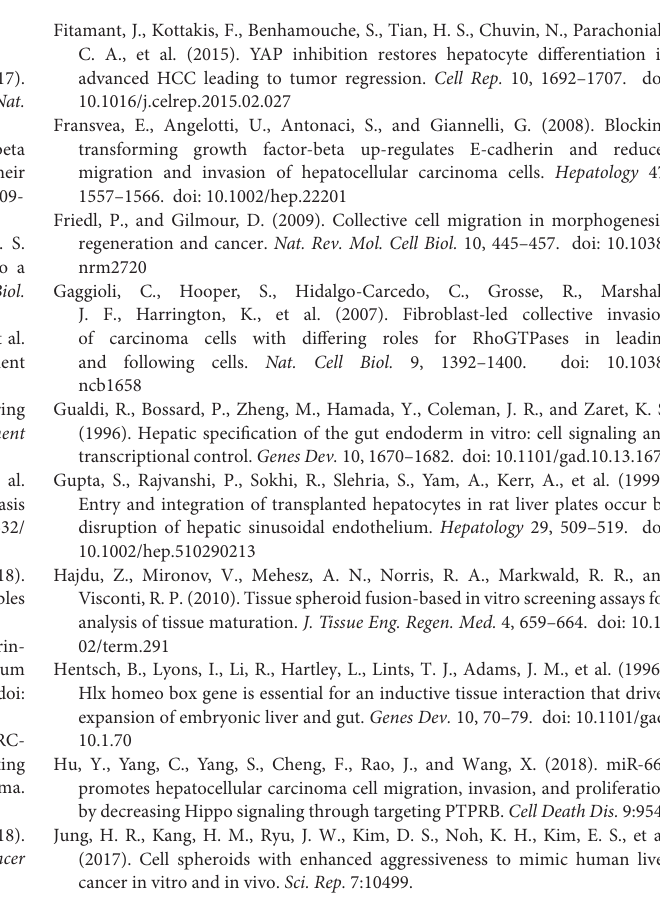
Supplementary Figure 10 | Spheroid outgrowth assay in control and M-CM medium with immunocytochemistry for E -cadherin. HepG2 spheroids seeded Supplementary Figure 11 | Images obtained of day 7 HepG2 MG droplet culture systems in MRC-5-conditioned media (MCM) and control experimental conditions (serum containing DMEM). The MCM condition is a lighter pink color than the control condition which is supportive evidence for the degradation of the MG by Supplementary Figure 12 | HepG2 spheroids cultured in 1:19 diluted MRC-5-conditioned media (M-CM) exhibit no matrix invasion. HepG2 spheroids formed in suspension culture using a 384-well round-bottom ultra-low attachment plate were harvested and seeded into MG droplets on tissue culture-treated 60 mm dishes. MG droplets were then cultured in 1:19 M-CM for an additional 4 days. On day 7, spheroids showed no significant outward migration into the extracellular matrix (ECM). The M-CM media typically supports extensive HepG2 migration.